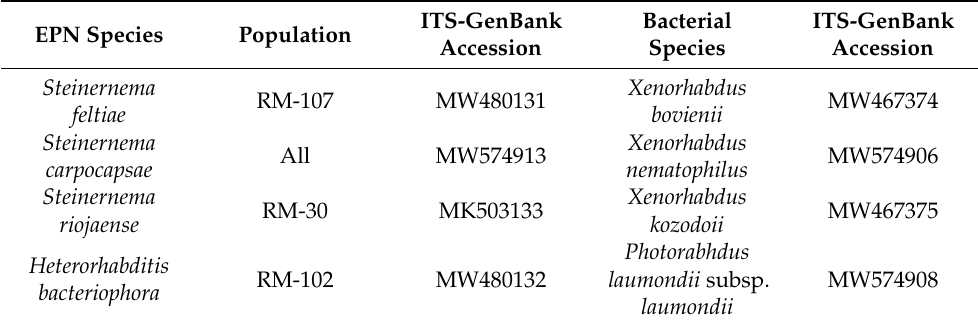
Table 1. Entomopathogenic nematode (EPN) and symbiotic bacterial species tested against nymphs of Philaenus spumarius